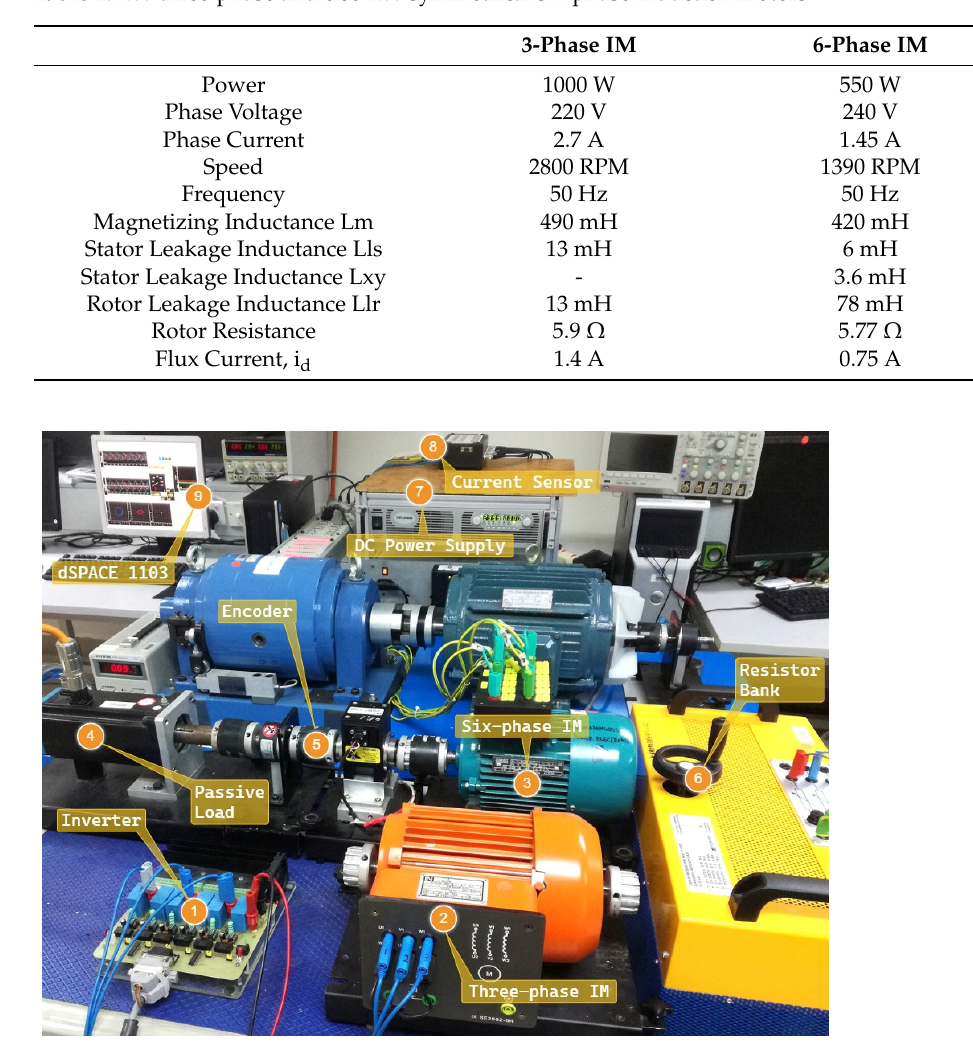
Figure 6. The experimental test rig for three-phase and six-phase induction motor drives under OPF.